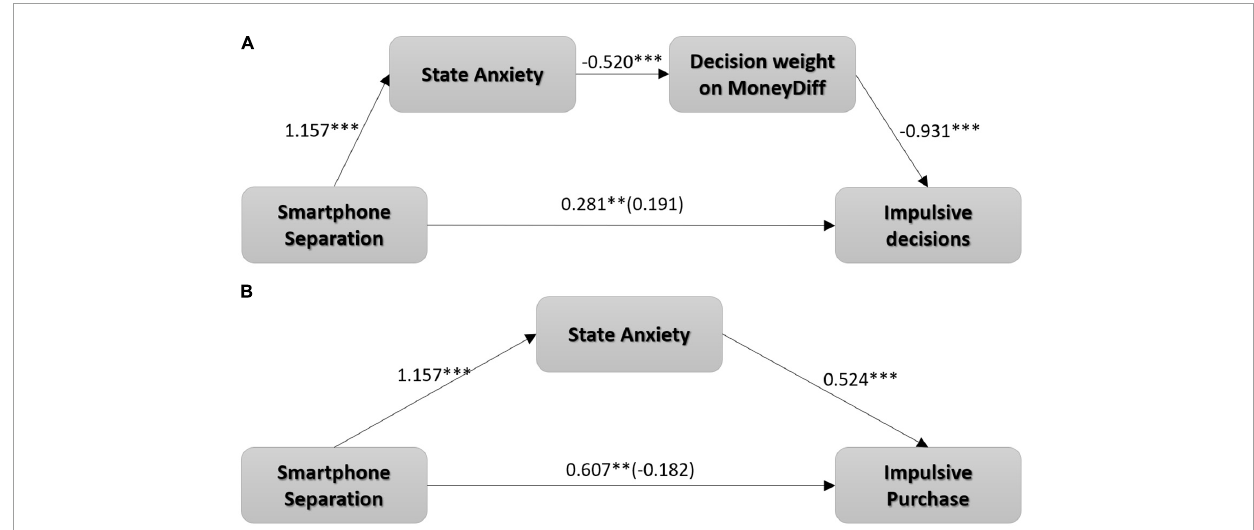
FIGURE6 (A) A dual mediation model for the serial indirect effect of smartphone separation on impulsive decisions through state anxiety and decision weight on MoneyDiff. (B) State anxiety mediated the effects of smartphone separation on impulsive purchase in the scenario of waiting for a meal in a restaurant. ∗∗ p < 0.01; ∗∗∗ p < 0.001.